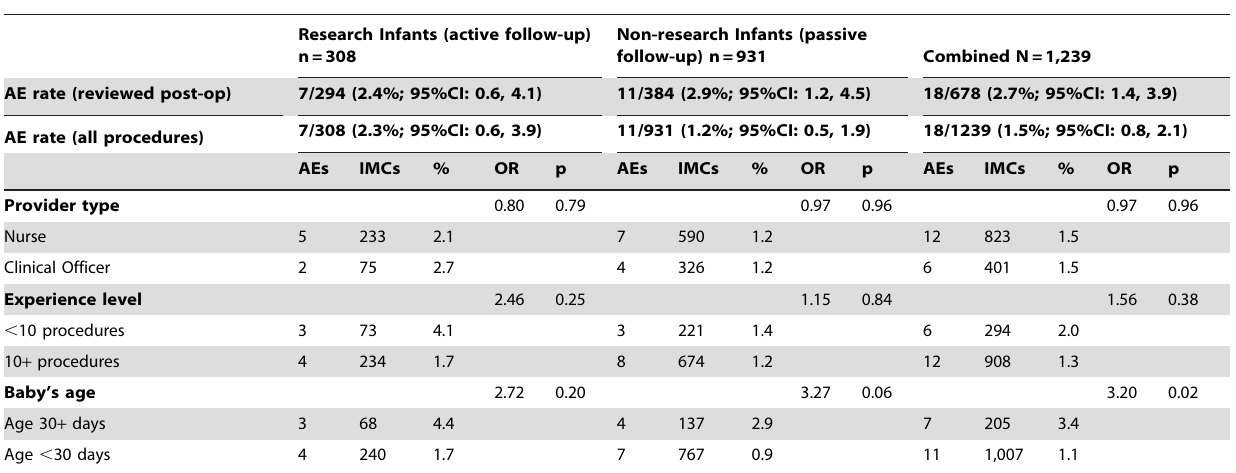
Table 3. Adverse event rate and risk factors for adverse events in research and non-research circumcisions.